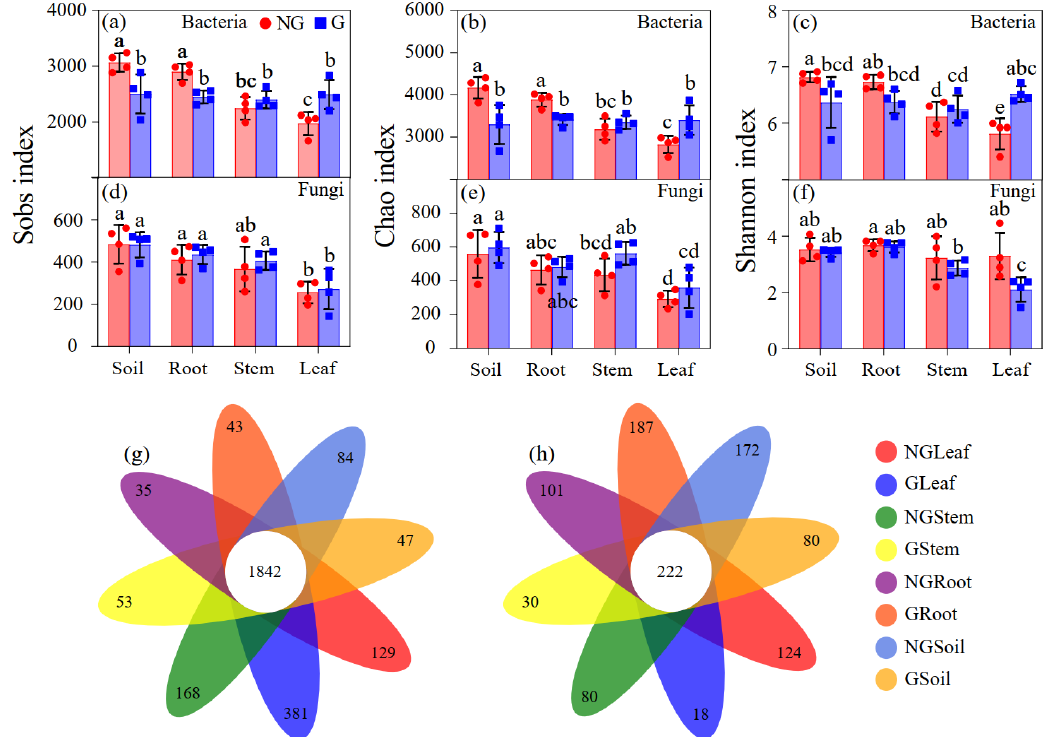
Figure 2. The composition of endophytic bacterial and fungal communities in rhizosphere and endosphere of Leymus chinensis grown in non-grazed and grazed grasslands. ( a – c ) Plots of Sobs, Chao, and Shannon indices of bacterial community at the OTU level. ( d – f ) Plots of Sobs, Chao, and Shannon indices of fungal communities at the OTU level. ( g , h ) Venn diagrams of eight groups based on microbial OTU. NG: non-grazed grassland; G: grazed grassland. Different letter indicates significant differences between grasslands ( p < 0.05).